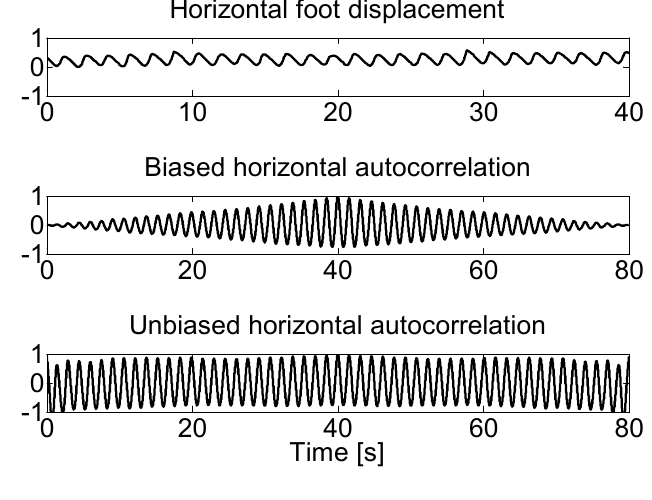
Figure 2. Horizontal foot displacement curve, biased and unbiased autocorrelation plots of normal